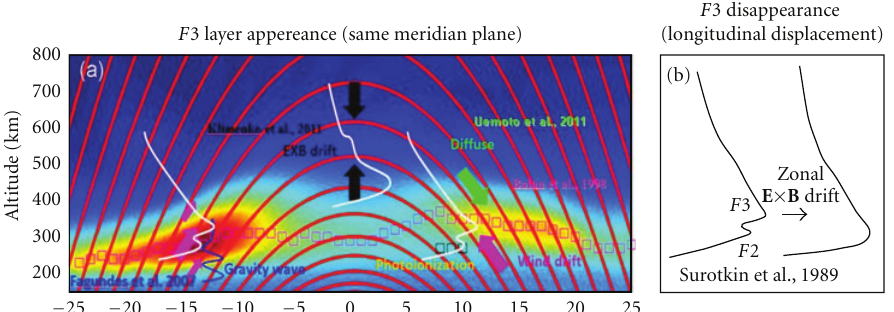
Figure 22: A schematic of the di ff erent mechanisms of the F2 layer stratification and all influenced